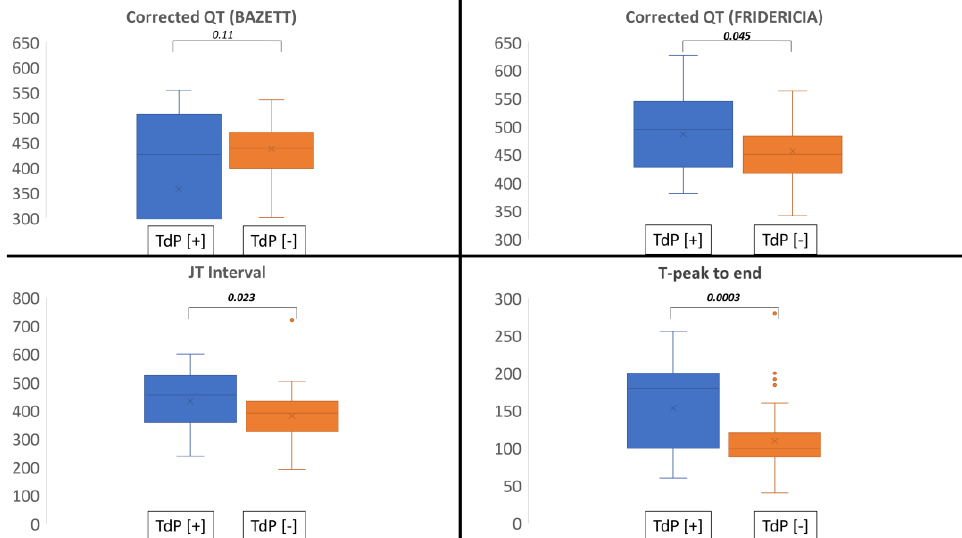
Figure 3. Box plots of corrected QT with Bazett’s formula ( upper left ), Fridericia’s formula ( upper right ), the JTc interval ( lower left ), and Tpeak-to-end ( lower right ) between the two groups. Bold, significant on statistical